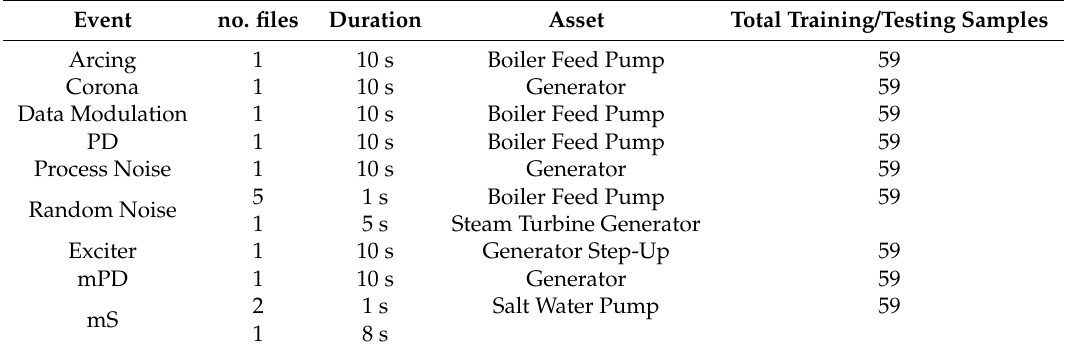
Table 1. Detected discharge sources in each